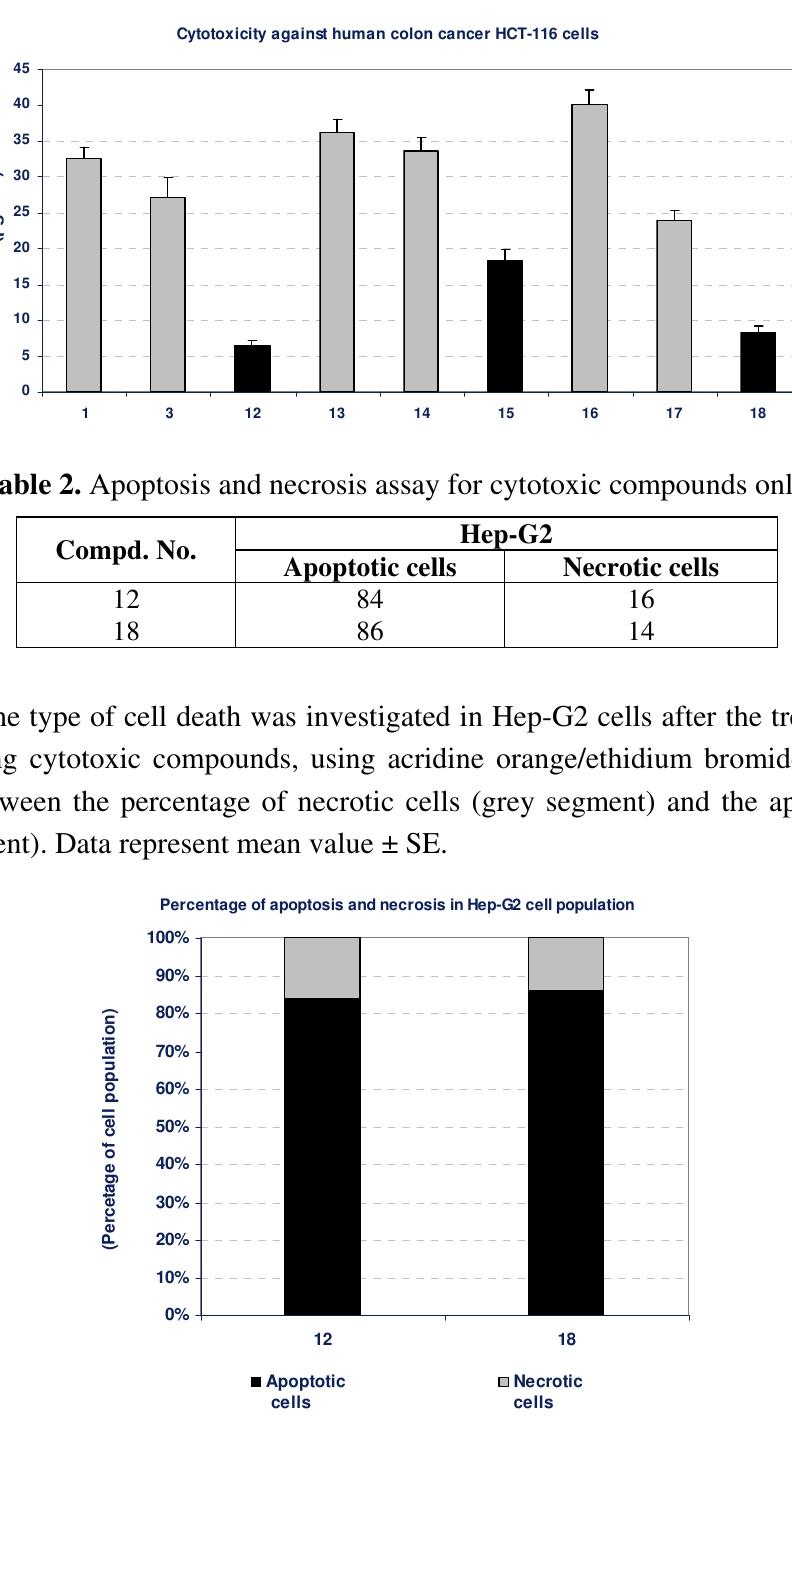
Figure 3. Cytotoxicity (IC50, µg/mL) of different tested compounds against human HCT-116 cells after 48 h of incubation. The grey bars represent non-cytotoxic compounds, and the black bars represent the promising cytotoxic compounds. Data represent mean value of IC ± SE. 50